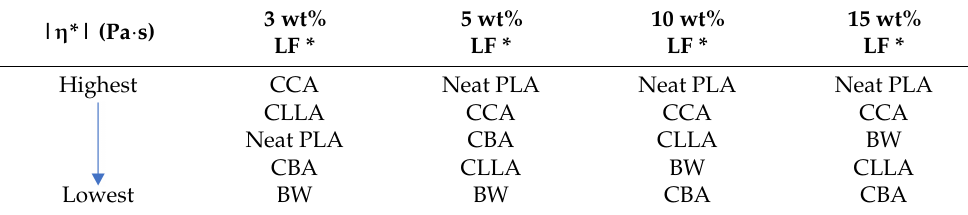
Figure 4. Complex viscosity of PLA–waxes (BW, CLLA, CBA, and CCA) blends at 3, 5, 10, and 15 wt% compared to PLA. ( a ) BW, ( b ) CLLA, ( c ) CBA, and ( d ) CCA. Table 3. Complex viscosity (| η *|) of PLA–wax biocomposites in the low-frequency range.